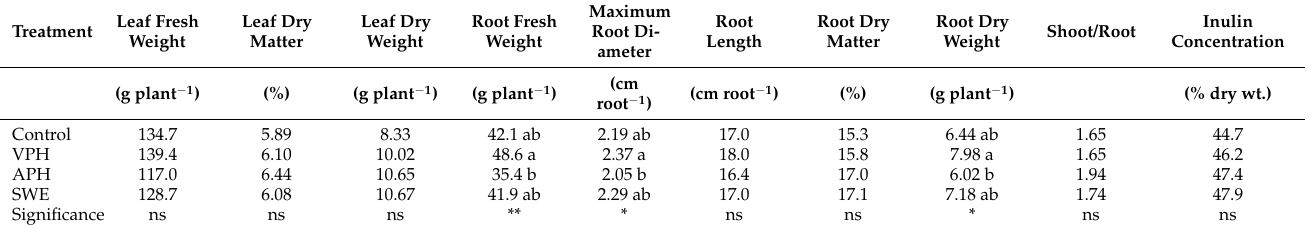
Table 3. Effects of plant biostimulants on fresh and dry biomass of leaves and roots, root characteris- tics, shoot to root ratio, and root inulin concentration in the greenhouse chicory